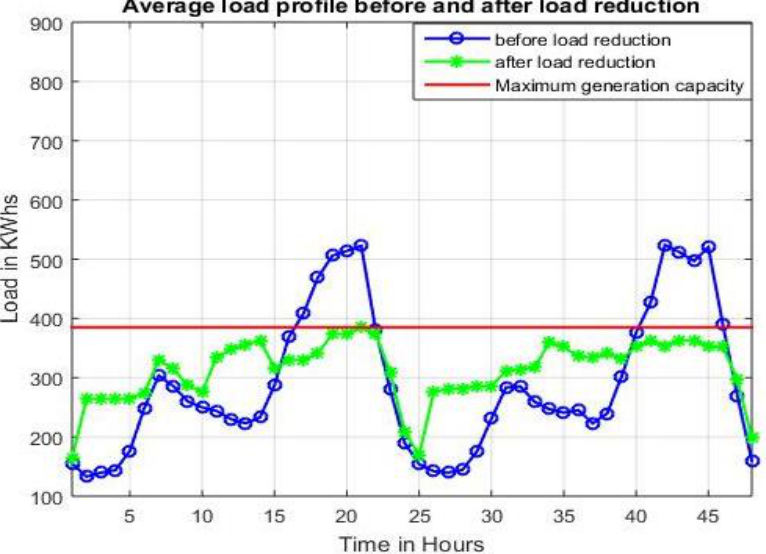
Figure 6. Average load profile before and after load reduction is presented.